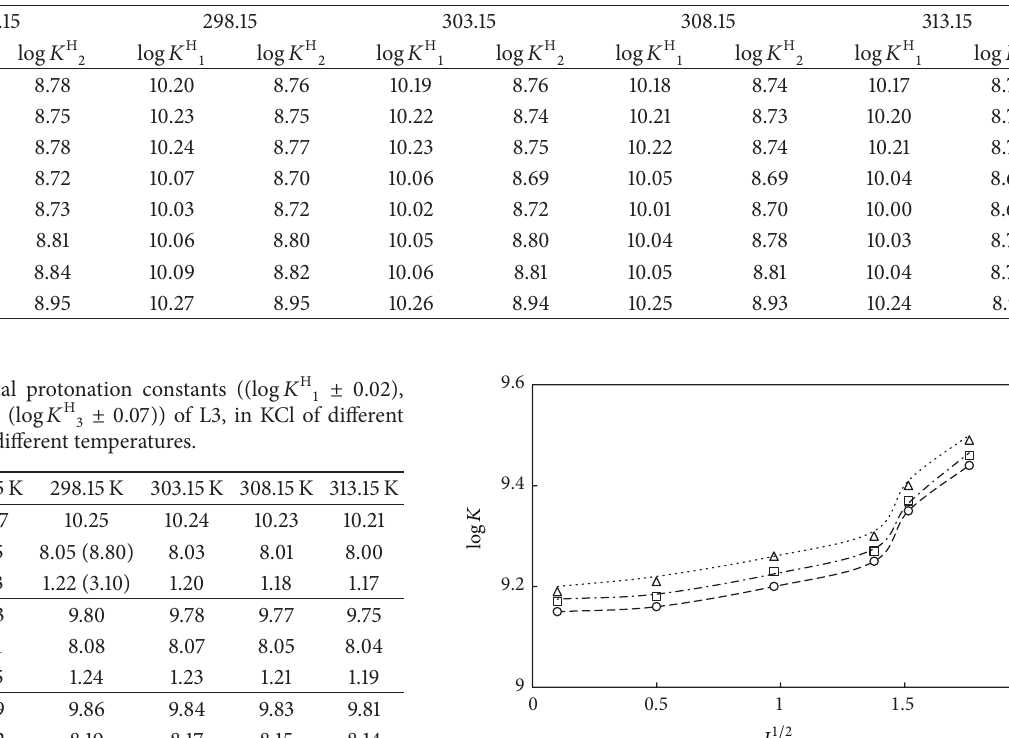
Table 2: Experimental protonation constants ((log 𝐾 H 1 ± 0.01 ) and (log 𝐾 H 2 ± 0.02 )) of L2, in KCl of different ionic strength and at different temperatures ( 𝑇 /K).